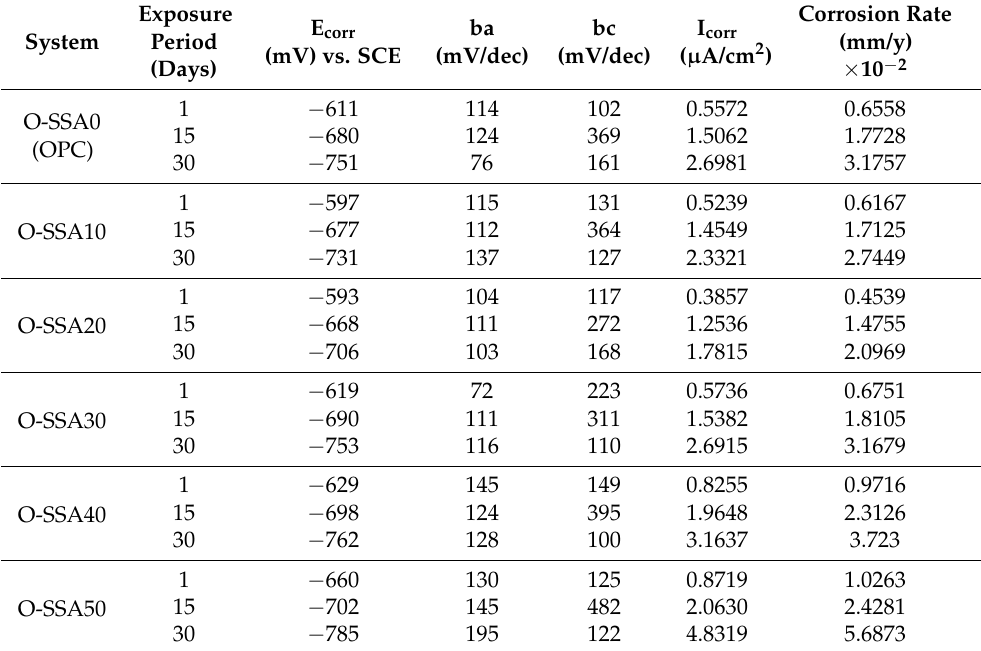
Table 4. Corrosion kinetic parameters for steel rebars in various cement extracts for a various exposure period obtained from Tafel